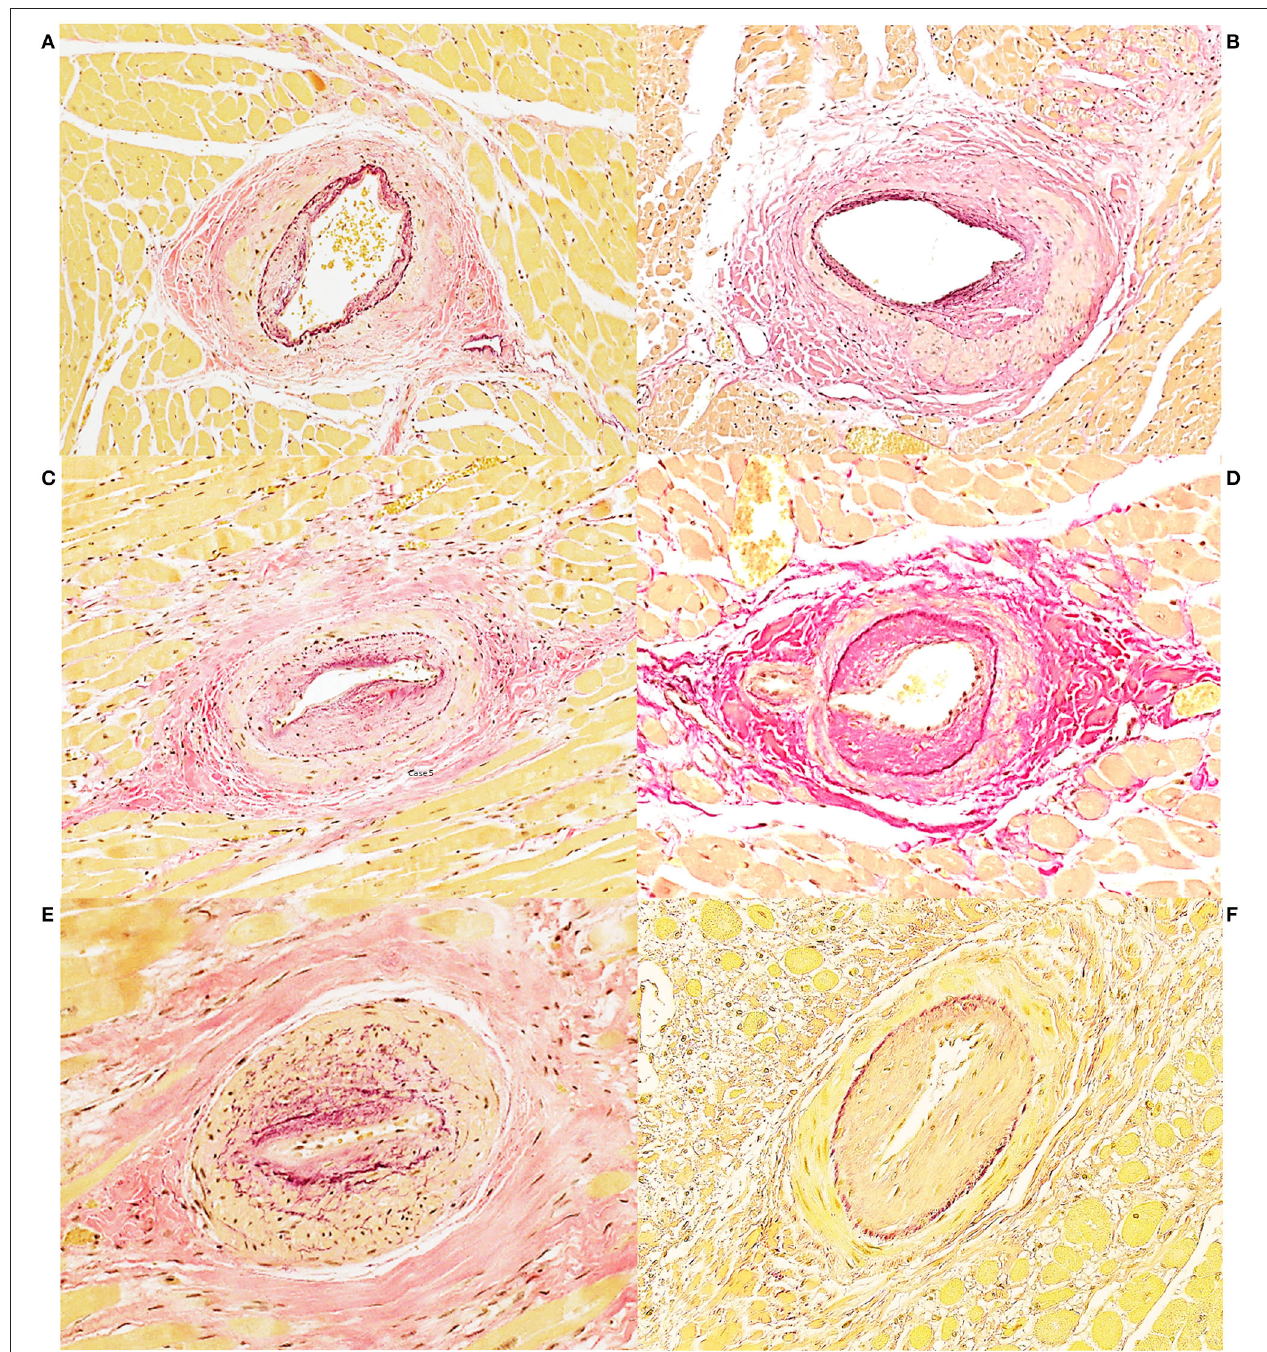
FIGURE 9 | Heart, Eurasian lynx ( Lynx lynx carpathicus ), coronary arteriosclerotic lesions, Van Gieson stain (A) case 5: Asymmetrical, mild to moderate thickening of the media with multifocal variable accumulation of myointimal cells and reduplication of the internal elastic lamina. Multifocal mild to moderate increase of collagen fibers in the media; (B) case 3: Asymmetrical moderate thickening of the media with abundant collagen deposition and segmental reduplication of the internal elastic lamina. (C) Case 5: Moderate to severe intimal thickening with moderate proliferation of the myointimal cells, partial reduplication and fragmentation of the internal elastic lamina and lumen reduction. (D) case 3: Severe intimal thickening with abundant collagen deposition. Moderate increase of collagen also within the media. (E) case 5: Severe luminal reduction with intimal and medial thickening. Exuberant internal elastic lamina reduplication and fragmentation (F) case 4: Severe intimal thickening with luminal reduction and moderate myointimal cells